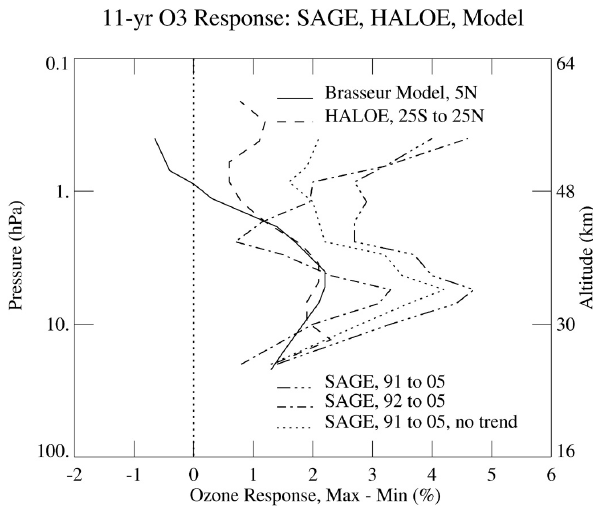
Fig. 15. Profiles of the 11-yr, max minus min ozone responses (in percent) from the Brasseur model (solid), HALOE data (dashed), and the SAGE II data from 91 to 05 (dash-dot-dot-dot), from 92 to 05 (dash-dot), and again from 91 to 05 but with no trend term